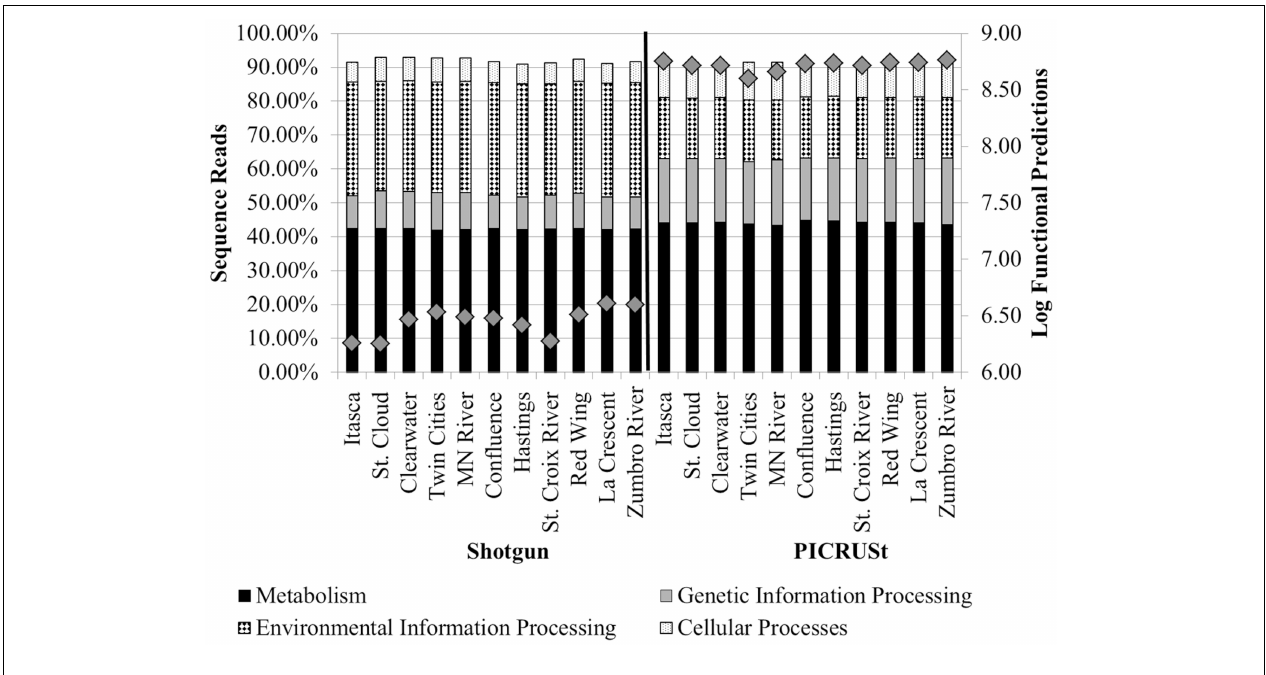
FIGURE 3 | Percentages of tier 1 KO functions among all shotgun metagenomic (left) and PICRUSt functional predictions (right). Functional categories for organismal systems and human diseases were